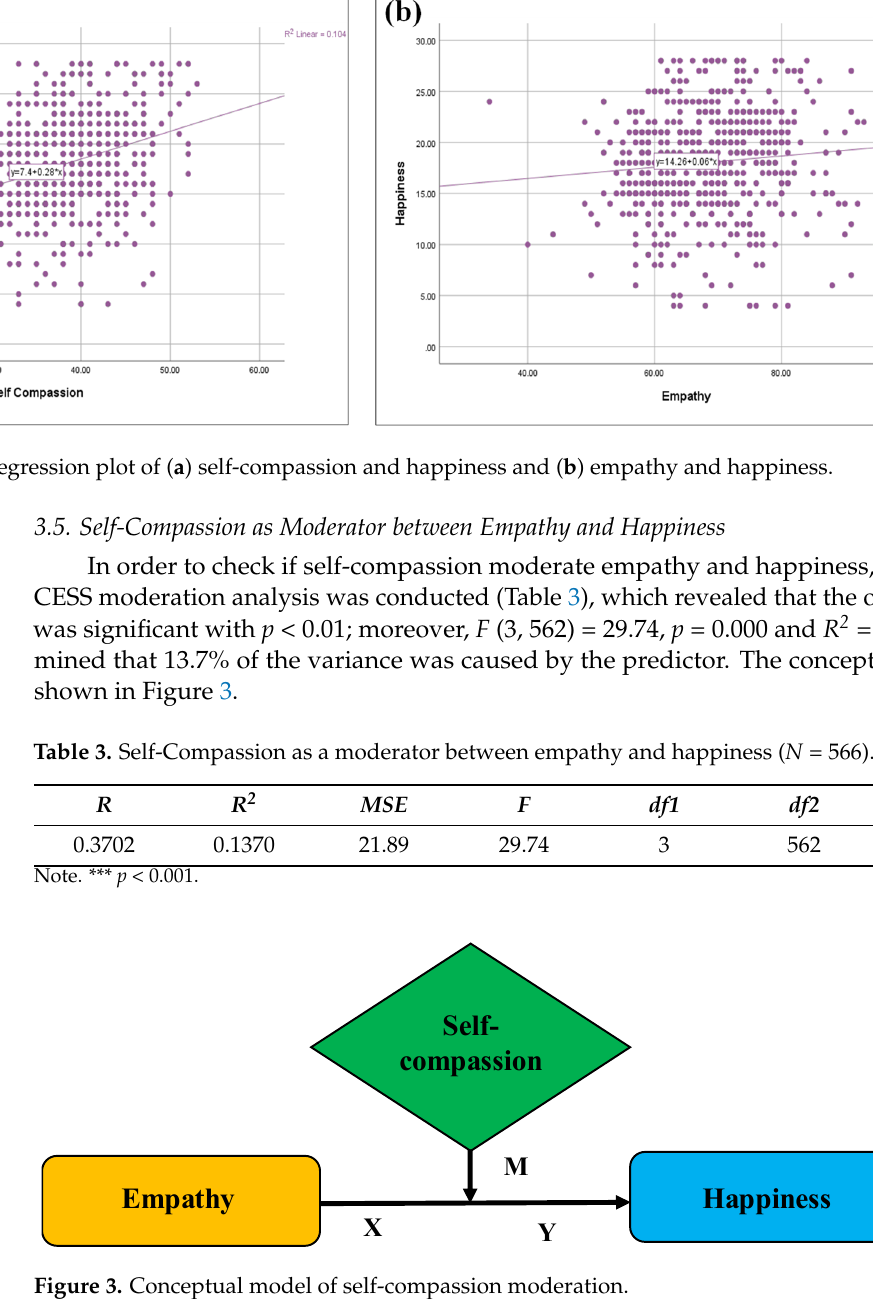
Table 2. Self-compassion and empathy as a predictor of happiness among late adolescents ( N = 566).